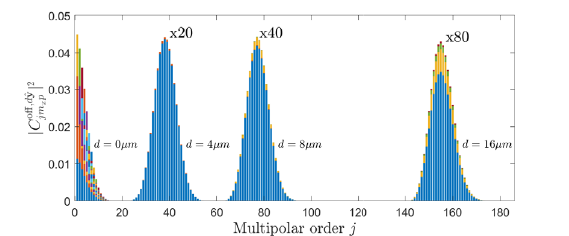
| 2 for the ro- Figure 2. Displaced beam shape function | C o ff , d ˆ y j , m x , p tated multipoles A ( y ) jm . The plots are done for NA = 0 . 4 and x d = 0 , 4 , 8 , 16 μ m. The blue color displays the weight of the mul- tipolar modes with m x = j , the yellow color shows the weights of m x = j − 1, etc. The plot with d = 0 μ m corresponds to the Figure 3. Scattering cross section σ sca as a function of λ for a on-axis beam shape function with m ∗ z = 1. The wavelength is sphere with R = 145 μ m, and n r = 1 . 3989. The sphere is illu- λ = 640 nm. minated with a displaced focused Gaussian beam with a well- defined helicity. The beam is displaced d = 150 μ m and the lens has an NA = 0 .